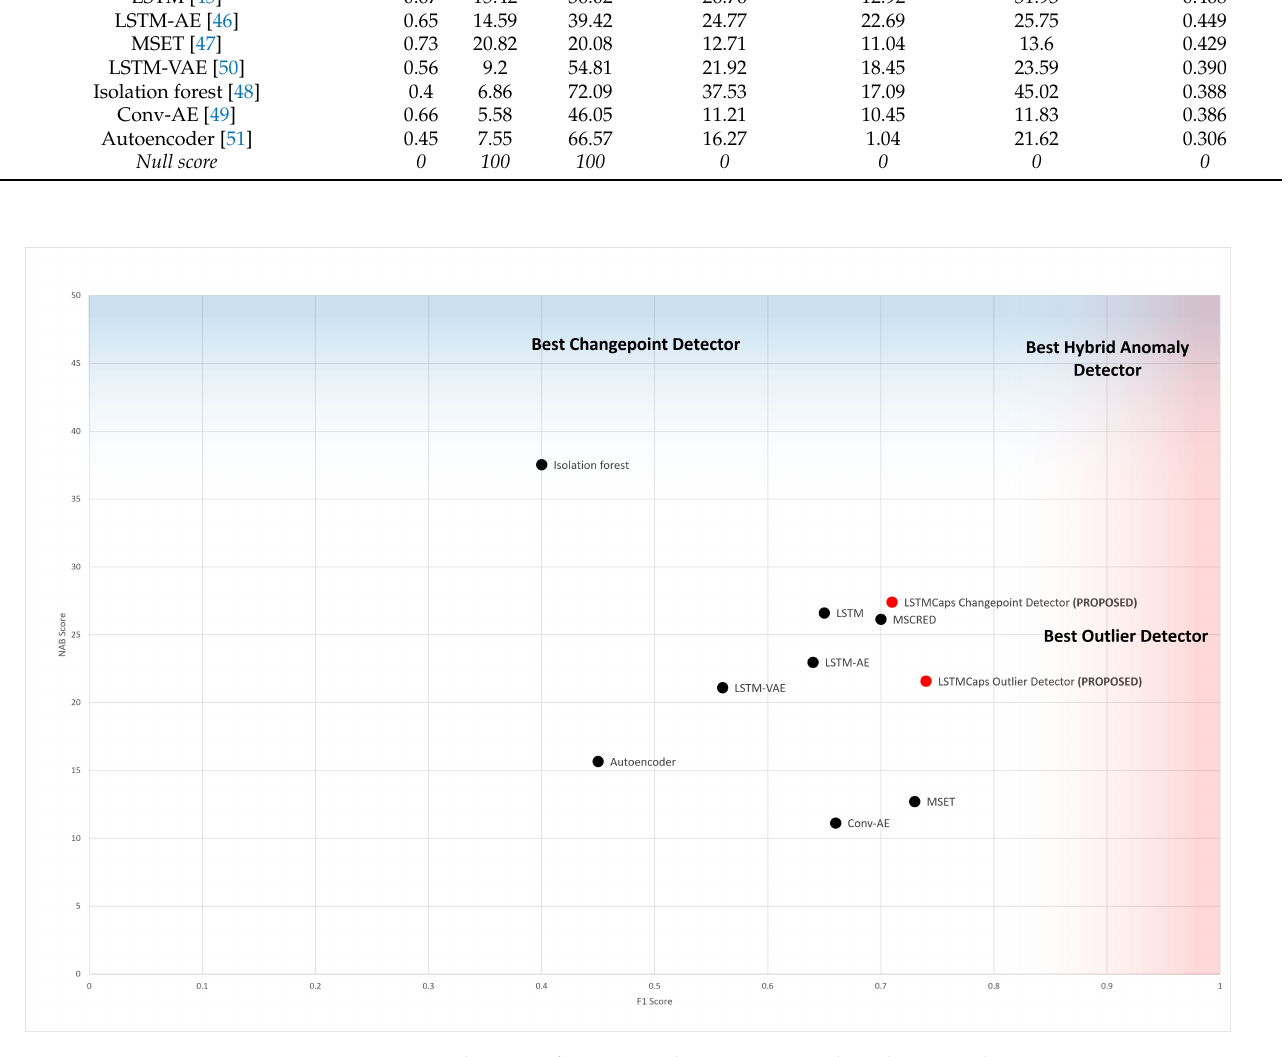
Figure 10. Visualisation of SKAB results: NAB score plotted against the F 1 score. Table 13. ANOVA source table for the overall accuracy scores of the SKAB